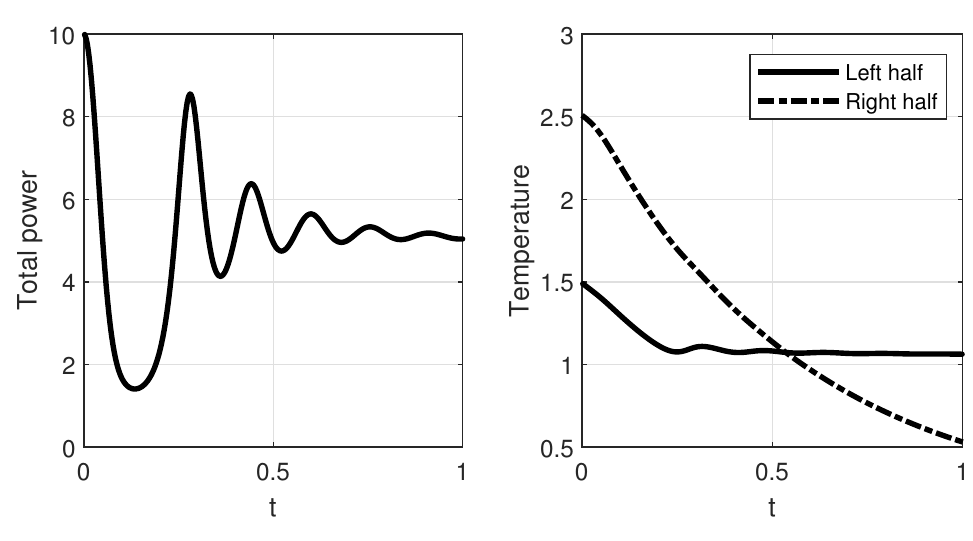
Figure 2. The reference solution for this contrived model as a function of time. Left: Total slab power. Right: Temperature of each